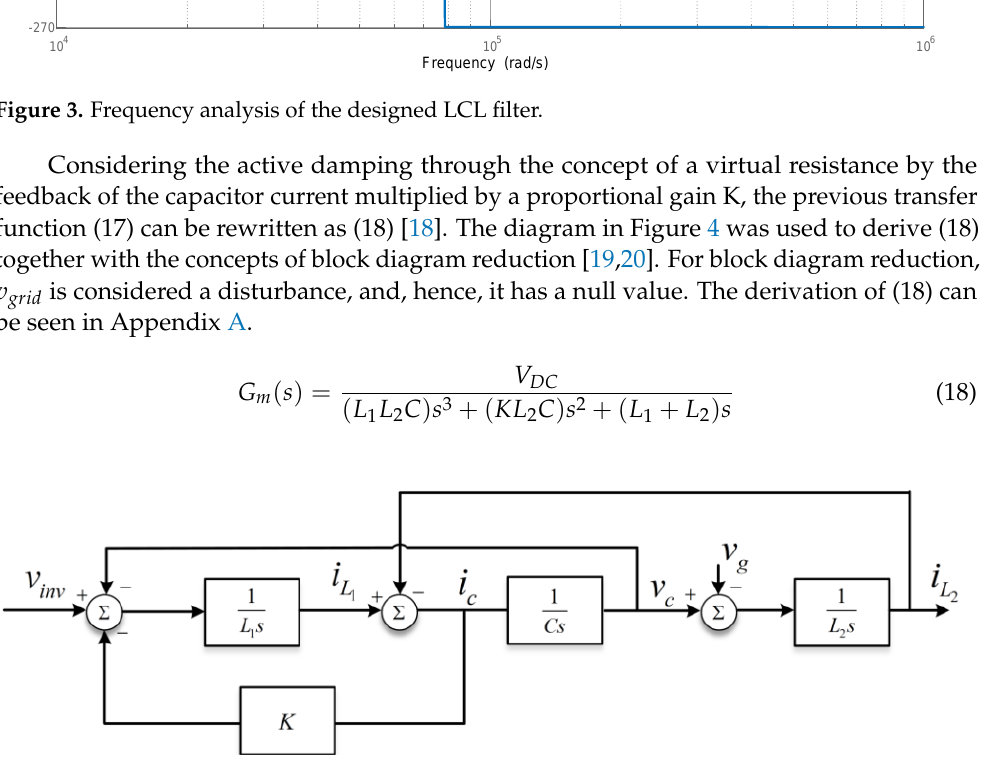
= mV = i = i 2 , and v g DC , i L 1 inv 1 , i L 2